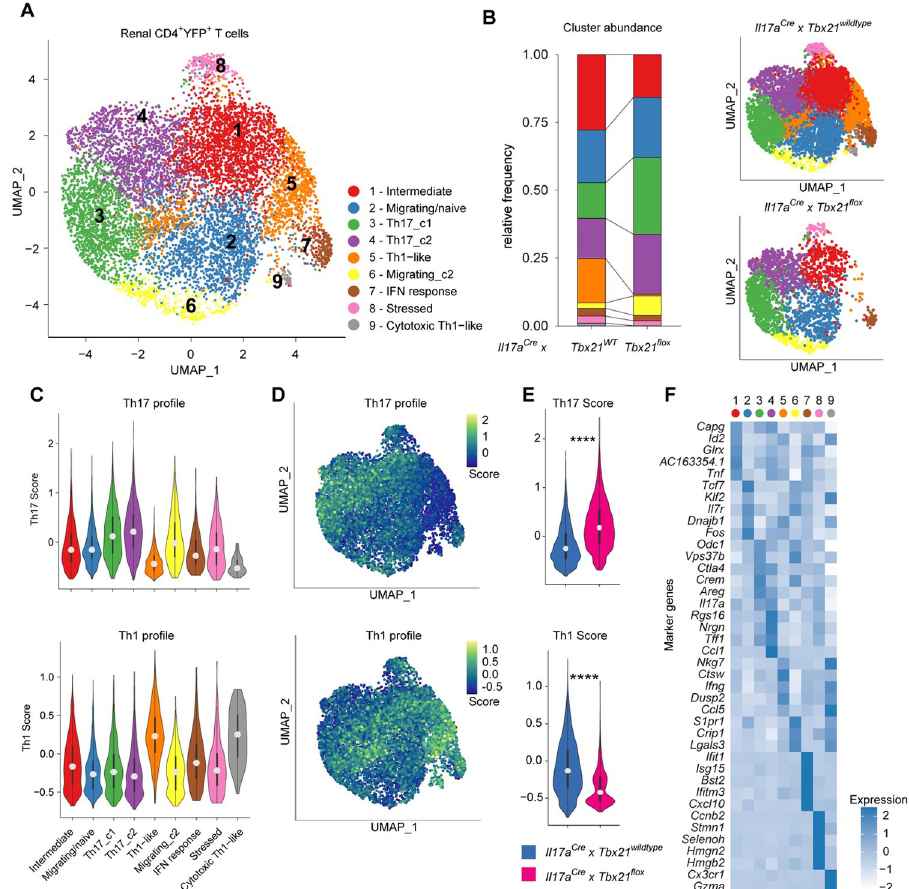
Fig 5. T-bet-deficiency affects Th17 plasticity to Th1-like ex Th17 cells in infected kidneys. (A) UMAP dimensional reduction and (B) Cluster abundance of renal YFP + CD4 + T cells 10 days after S . aureus infection of Il17aCre x R26eYFP x Tbx21-wildtype (cells pooled from n = 7 mice) and Il17aCre x R26eYFP x Tbx21-flox (cells pooled from n = 6 mice) mice analyzed by single cell RNA-sequencing. (C) Th17 and Th1 scores in the clusters as indicated. (D) Comparison and (E) Quantification of Th17 and Th1 scores in cells from Tbx21-flox and Tbx21-wildtype mice; Wilcoxon test, two sided, ���� p < 0.0001. (F) Differential gene expression of the top five genes most specific for each cluster of renal YFP + CD4 + T cells 10 days after S . aureus infection. infected Il17aCre x R26eYFP x Tbx21-flox mice. In this mouse model, Th17 cells and their progeny acquire permanent T-bet/ Tbx21 -deficiency. To compare the transcriptional profiles of Th17 with and without T-bet, we performed scRNA-seq analysis of FACS-sorted CD4 + YFP + T cells from Il17aCre x R26eYFP x Tbx21-flox mice at day 10 after S . aureus infection. Integrating the scRNA-seq data from Tbx21- wildtype and Tbx21 -deficient Th17 cells revealed nine different clusters that were annotated according to their gene expression (Fig 5A). One cluster of Th1-like cells was almost absent in T-bet -deficient Th17 cells from Il17aCre x R26eYFP x Tbx21-flox mice (Fig 5B). Gene expression analyses revealed Th17 associated genes in clusters 3 (Th17_c1) and 4 (Th17_c2) and Th1 associated genes in cluster 5 (Th1-like) and 9 (cytotoxic Th1-like) (Fig 5C and 5D). In addition, Th17 fate cells from Il17aCre x R26eYFP mice showed a higher Th1 score and Th17 cells from Il17aCre x R26eYFP x Tbx21-flox infected mice showed a higher Th17 score (Fig 5E).